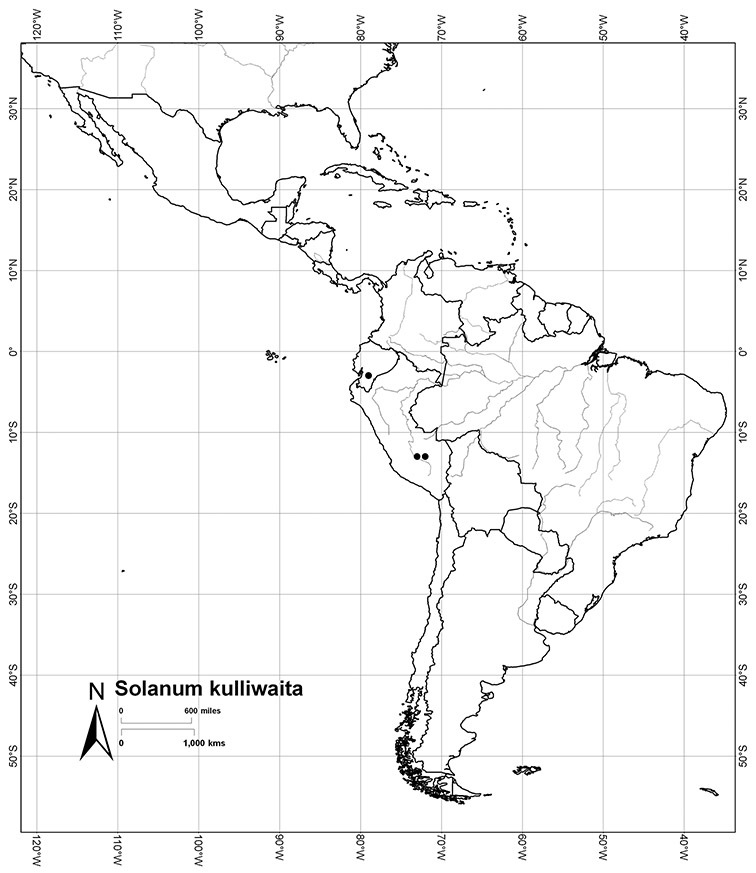
Distribution of Solanum kulliwaita S.Knapp.